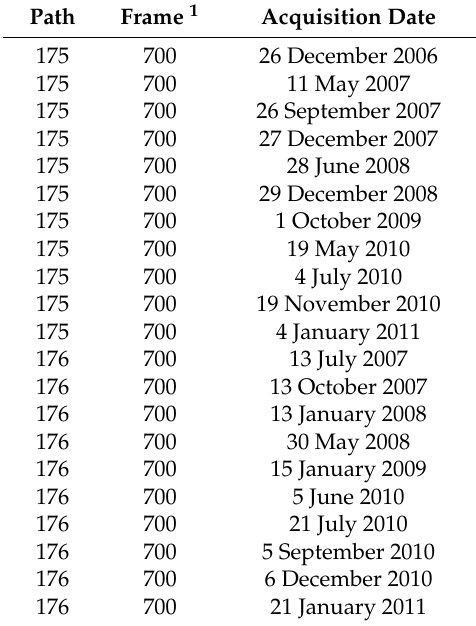
Table 1. Advanced Land Observing Satellite/ Phased Array L-Band SAR (ALOS/PALSAR)